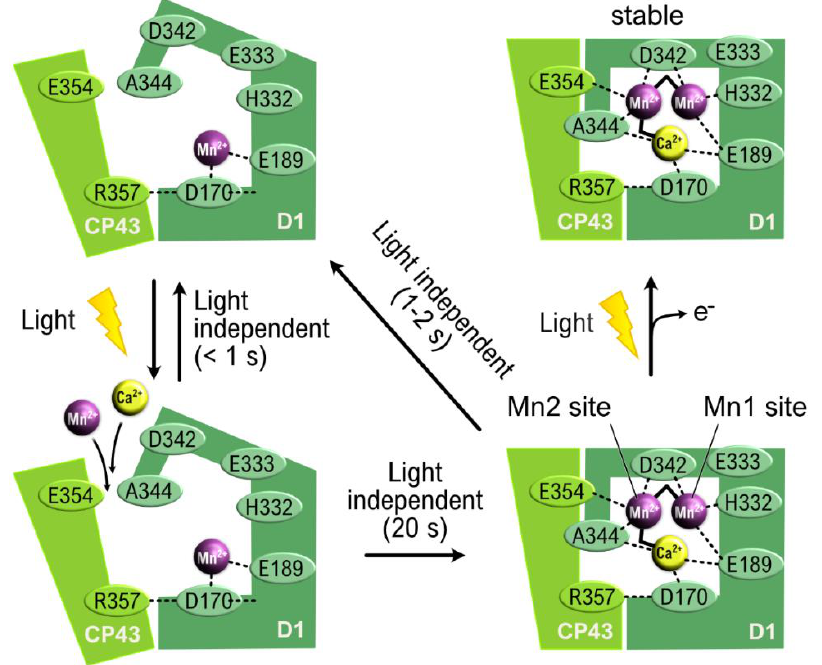
Figure 7. The initial stages of photoassembly of the OEC; redrawn and modified from Sato et al. [64]. The first light reaction is counteracted by a dark reaction that is much faster than incorporation of calcium ions, a second manganese ion, and rearrangement of the protein scaffolding. This leads to an overall low quantum yield.